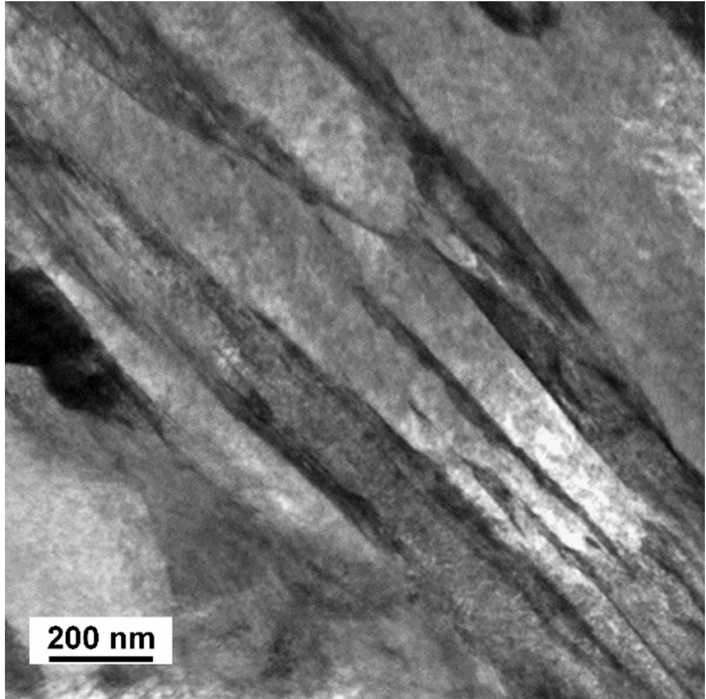
Figure 4. Lath martensite which formed during quenching of 42SiCr steel.